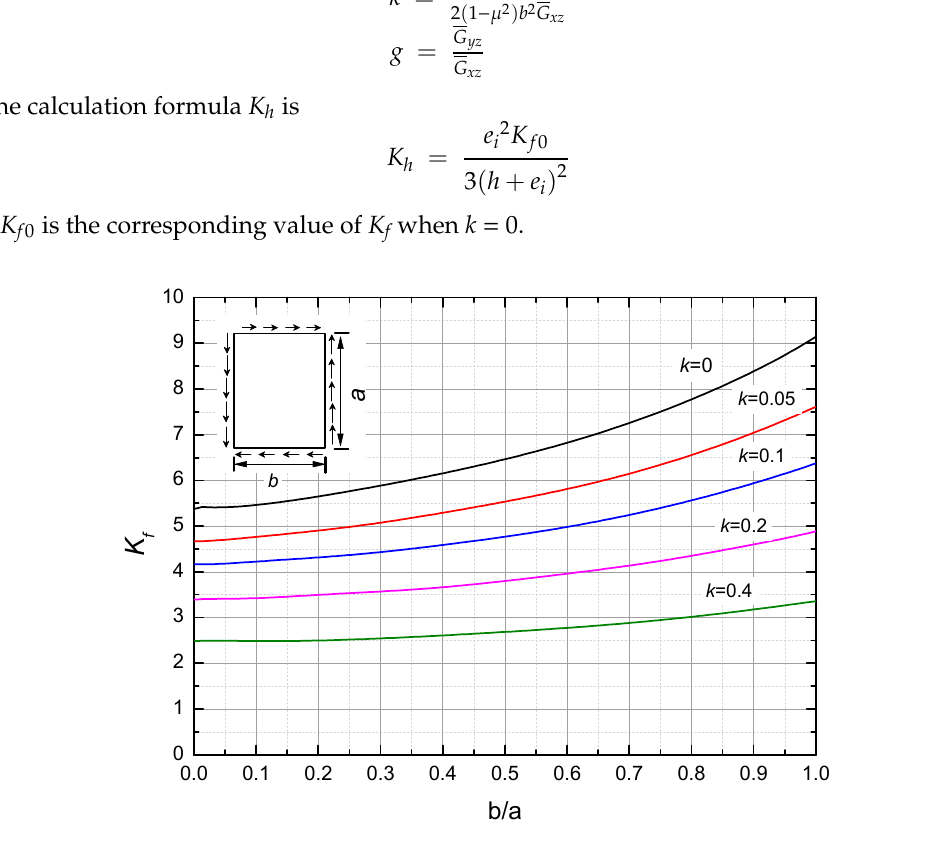
Figure 8. K f vs. b / a and k curves simply supported at four sides of the boundary Figure 8. K f vs . b/a and k curves simply supported at four sides of the boundary condition.